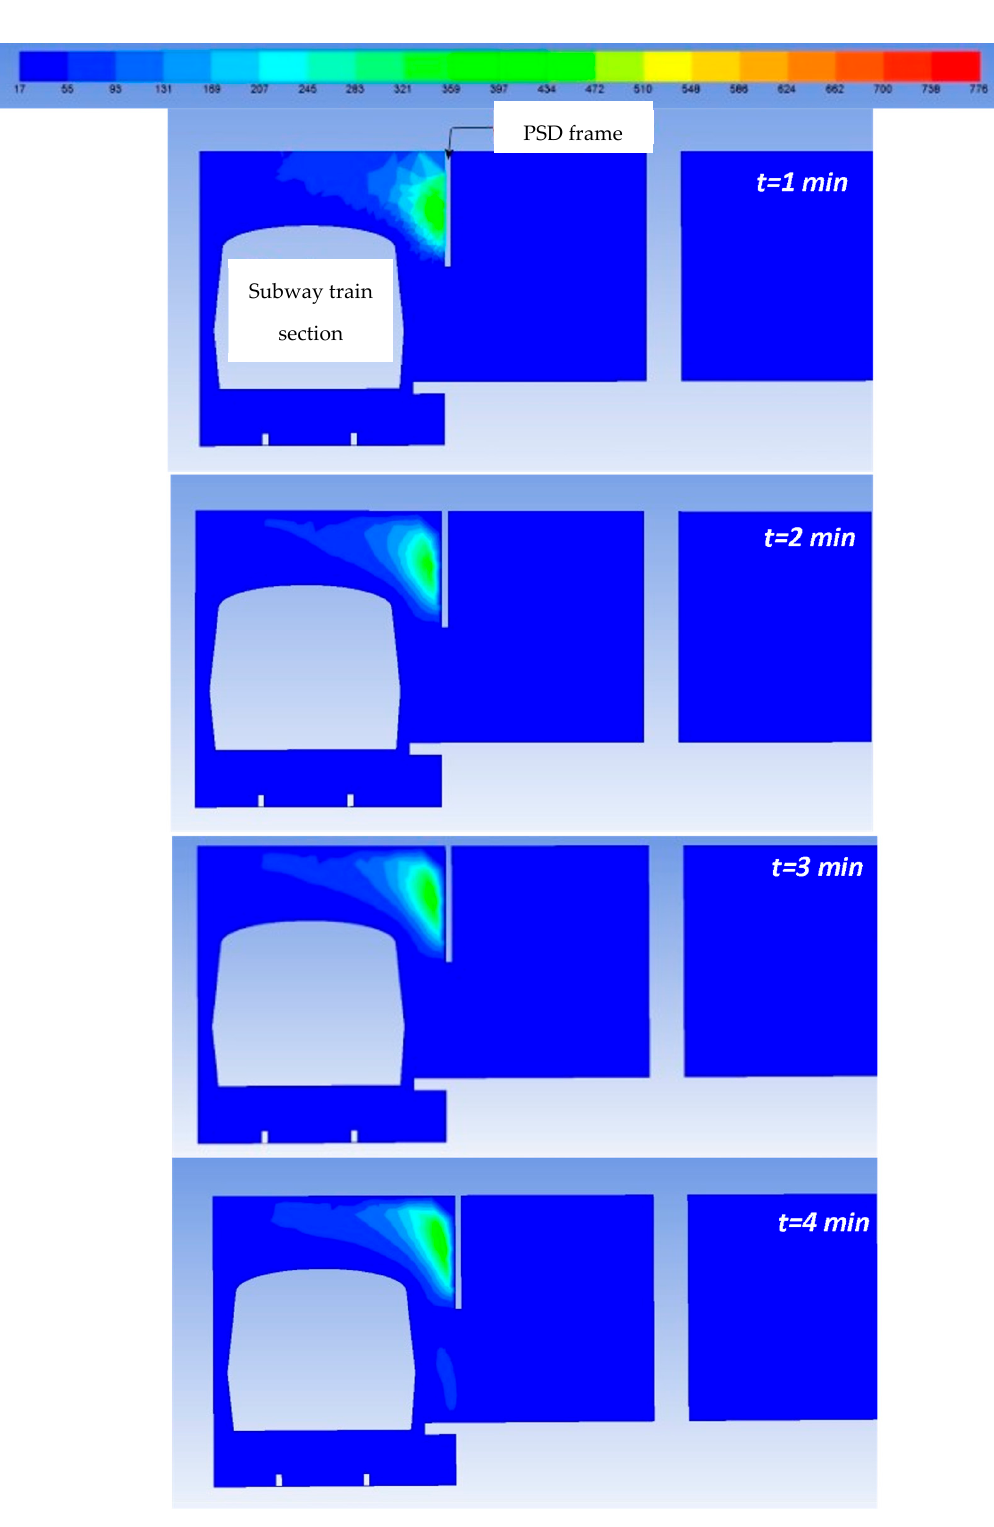
Figure 18. Temperature contours (°C)—cross section through the door of the PSD system near the fire outbreak (minutes 1–4).